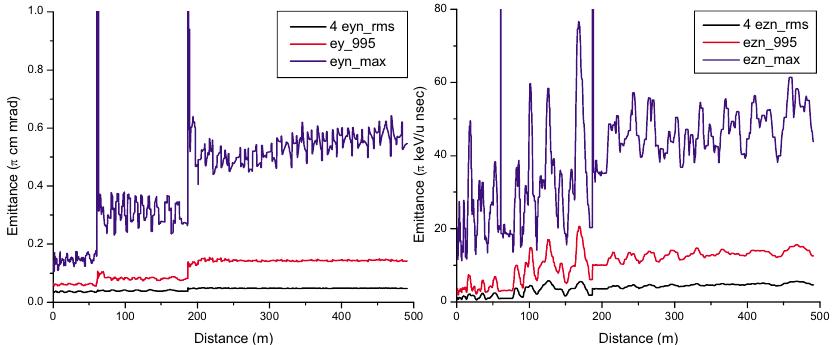
FIG. 10. (Color) Beam normalized emittances (4 rms, 99.5% and 100%) in the vertical and longitudinal planes as a function of the distance along the linac.